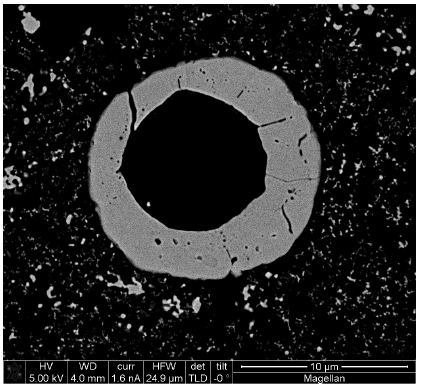
Figure 12. Empty oxide shell collected on chamber floor following burn.